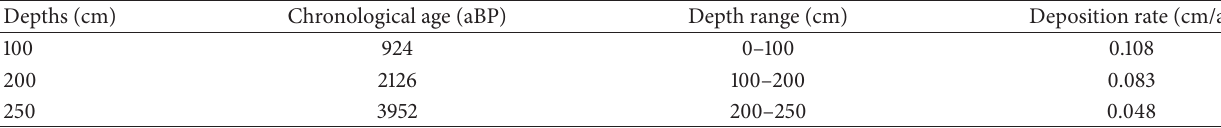
Table 1: AMS 14 C dating data and deposition rate of foraminiferal sediments samples.